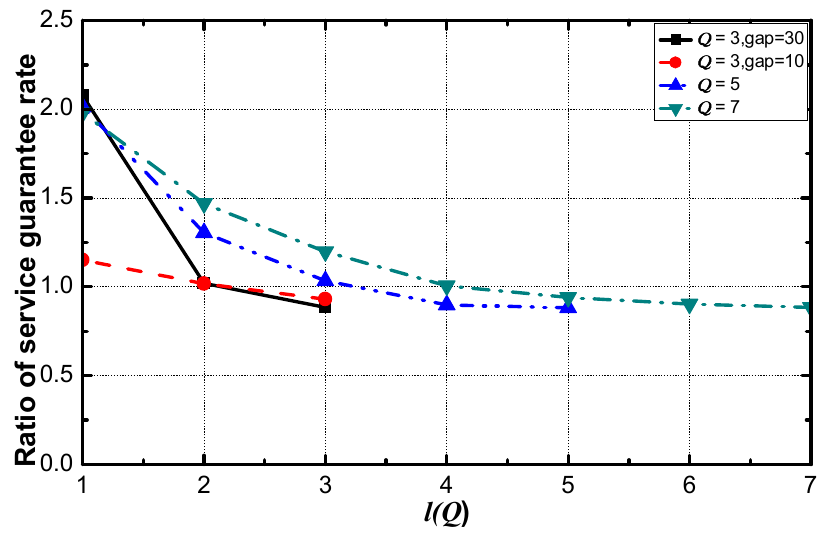
Figure 9. The ratio of service guarantee rate under different cases.